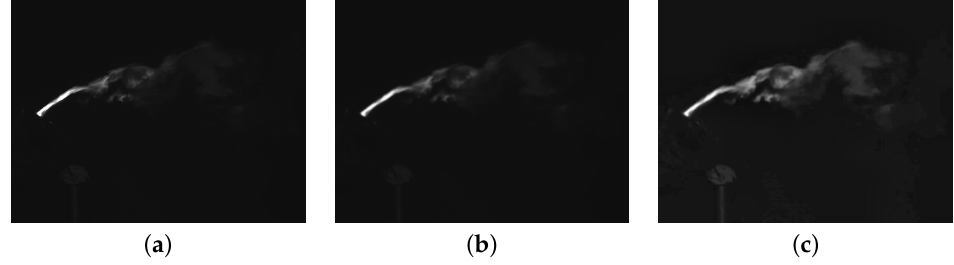
Figure 10. Image preprocessing: ( a ) original frame, ( b ) Gaussian blur, and ( c ) CLAHE filter. At this point, each consecutive pair of frames was processed using the Farnebäck algorithm [37] for the dense optical flow computation. The map of the velocity, expressed in pixels/frame, of each pixel between the reference frame and the arrival frame was calculated. This method for two-frame motion estimation was based on polynomial expansion in an